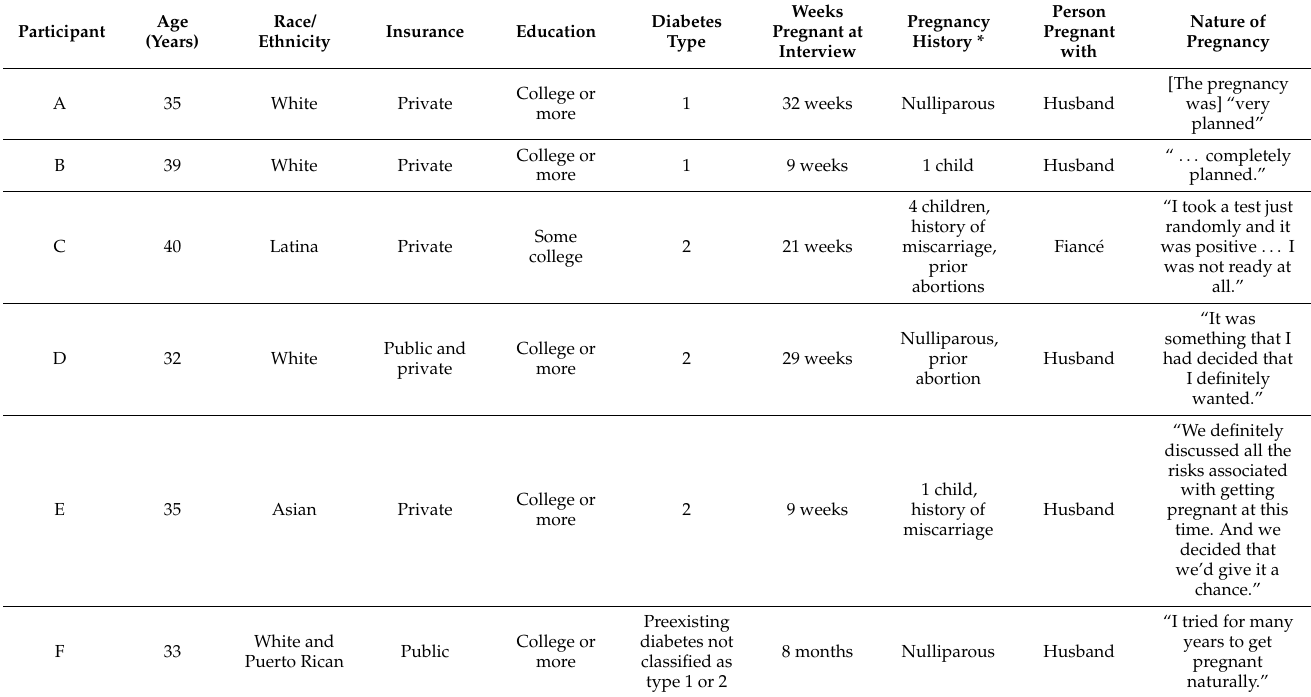
Table 1. Participant